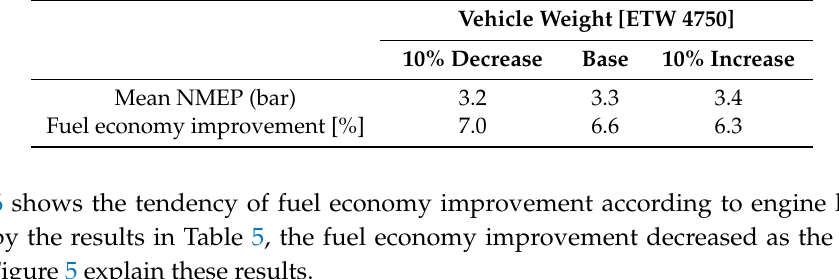
Table 5. Summary of fuel economy improvement by weight change in FTP-75.